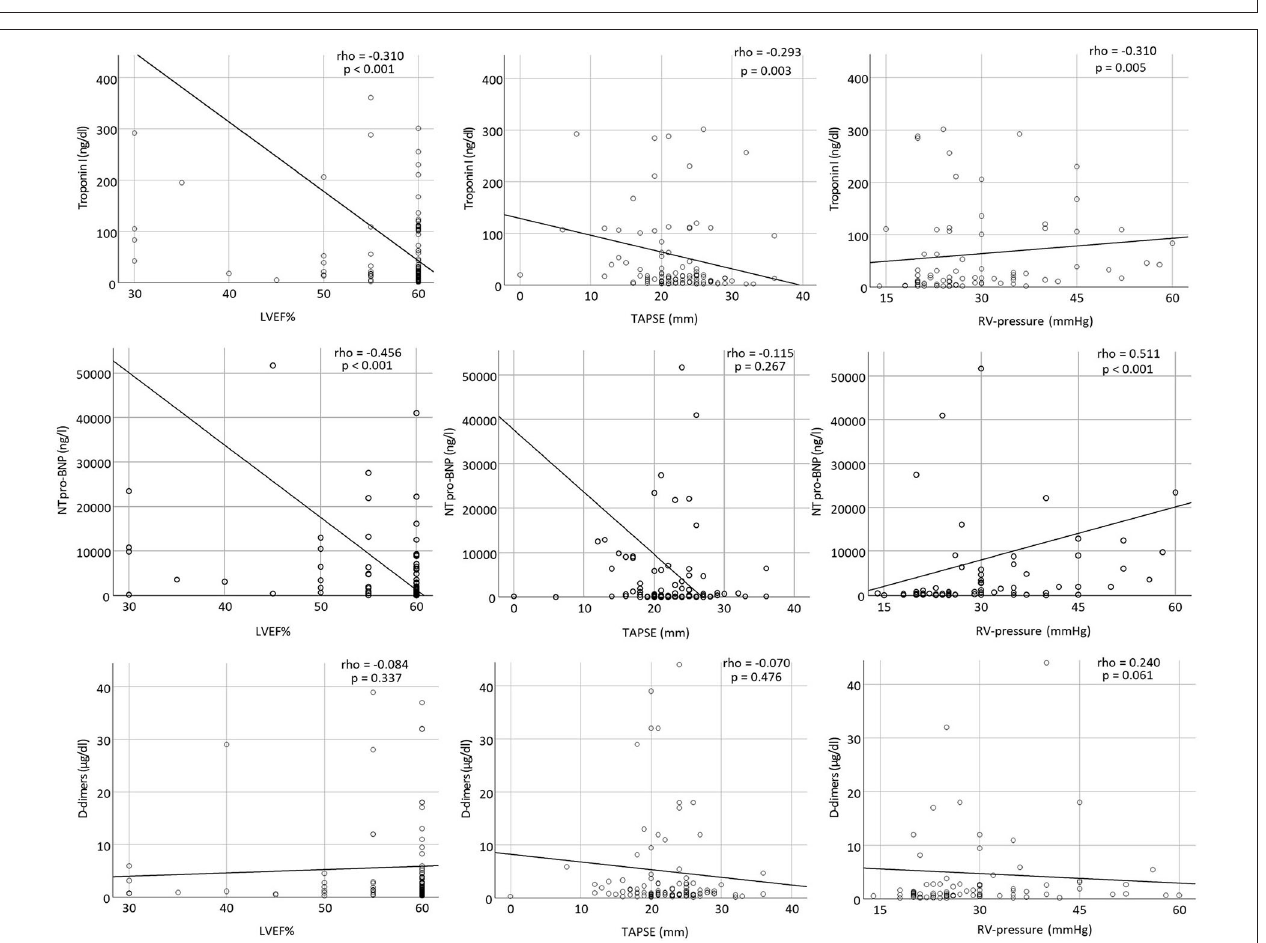
FIGURE 3 | Scatter plots showing correlations between troponin I, NT-pro-BNP, and D-dimers with LVEF%, TAPSE, and RV-pressure at admission.